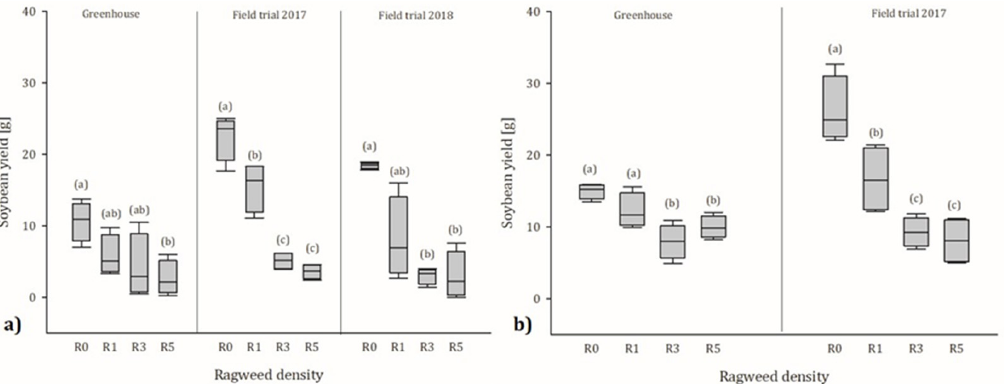
Figure 2. Soybean grain yield per plant, dependent on the ragweed density (0, 1, 3, and 5 plants: R0, R1, R3, and R5) of ( a ) cultivar Albenga and ( b ) cultivar ES Mentor, separated by trial (n = 4; different letters indicate significant differences).